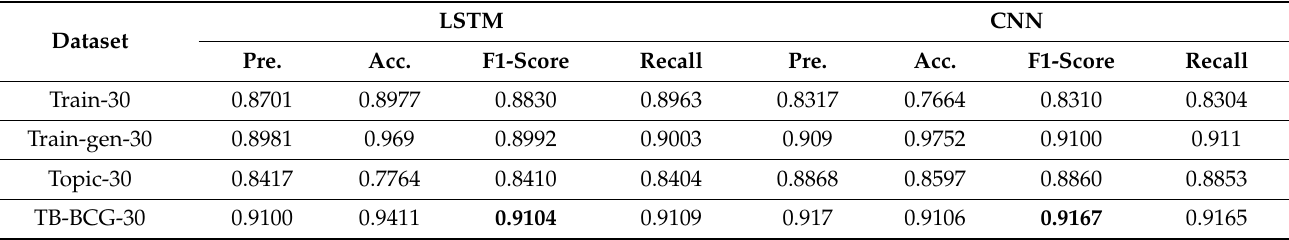
Table 7. Experimental result of 30% dataset.